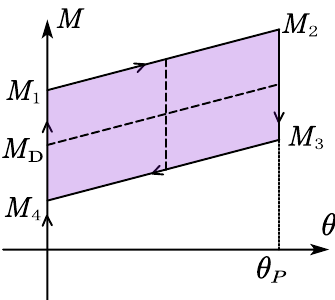
Figure 4. 𝑀 - 𝜃 curve of the